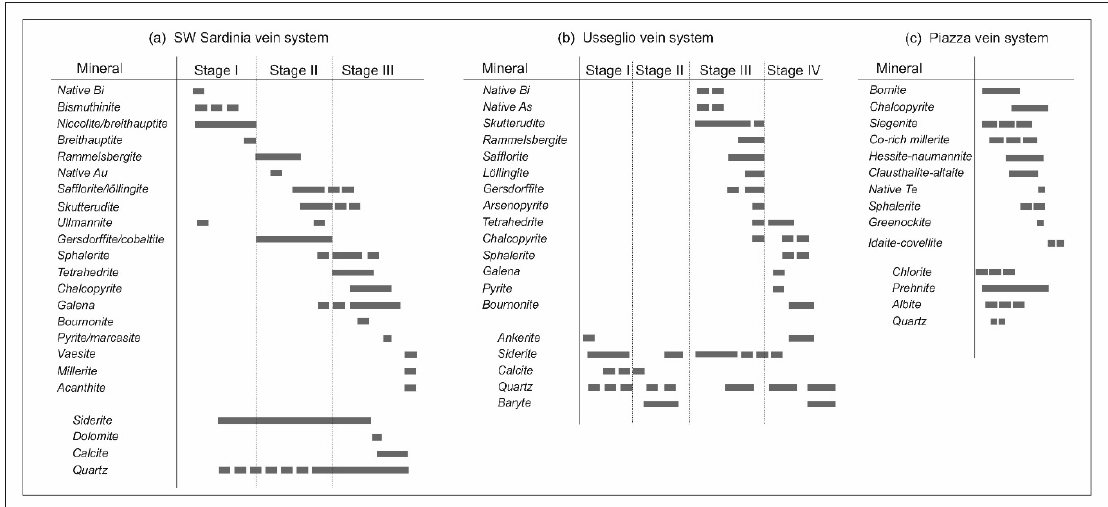
Figure 3. Paragenetic schemes for the mineral deposits considered: SW Sardinia ( a ), Usseglio ( b ), Usseglio and Piazza ( c ).